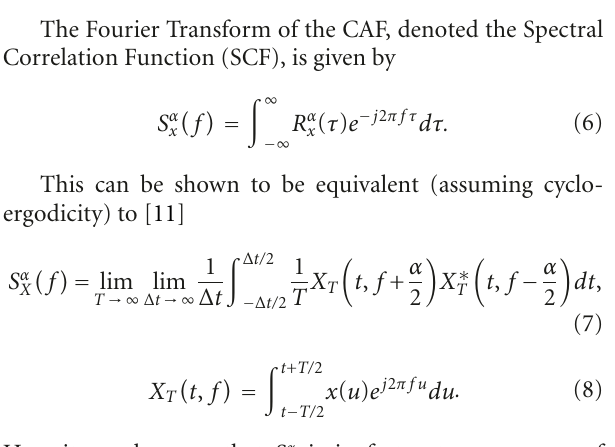
Figure 2: SOF of a BFSK signal in an AWGN Channel at 5dB SNR, with 1/Ts = Fs/10, Fc = 0.25 Fs, no. of samples =